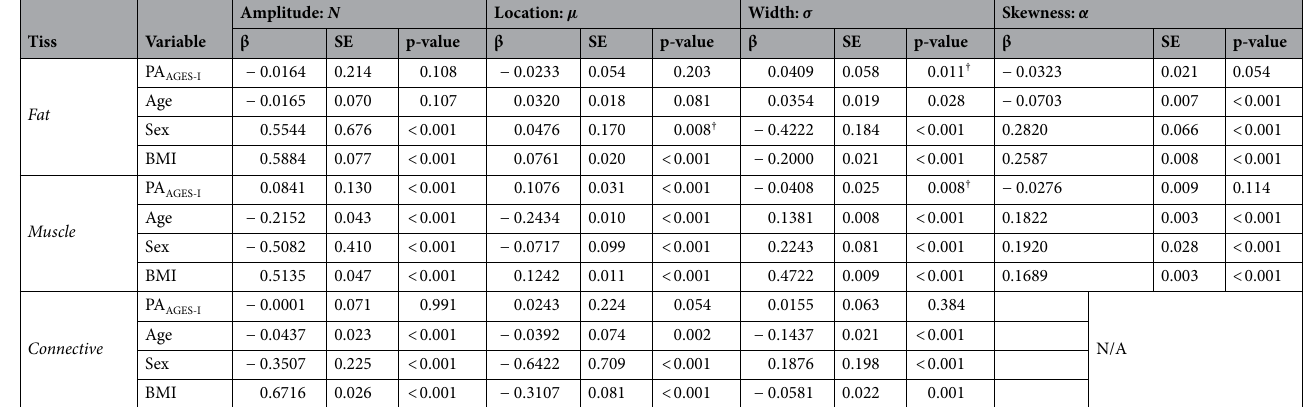
Table 3. Multivariate multiple regression models of the relationship between PA AGES-I and hypothesized NTRA AGES-II mediators. † p-value did not surpass HB correction for multiple comparisons.